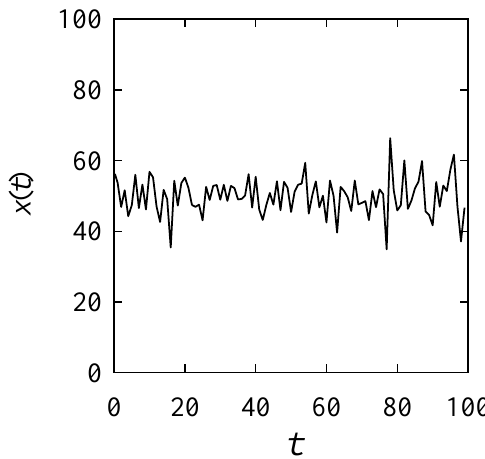
Figure A4. A given set of numerical data.